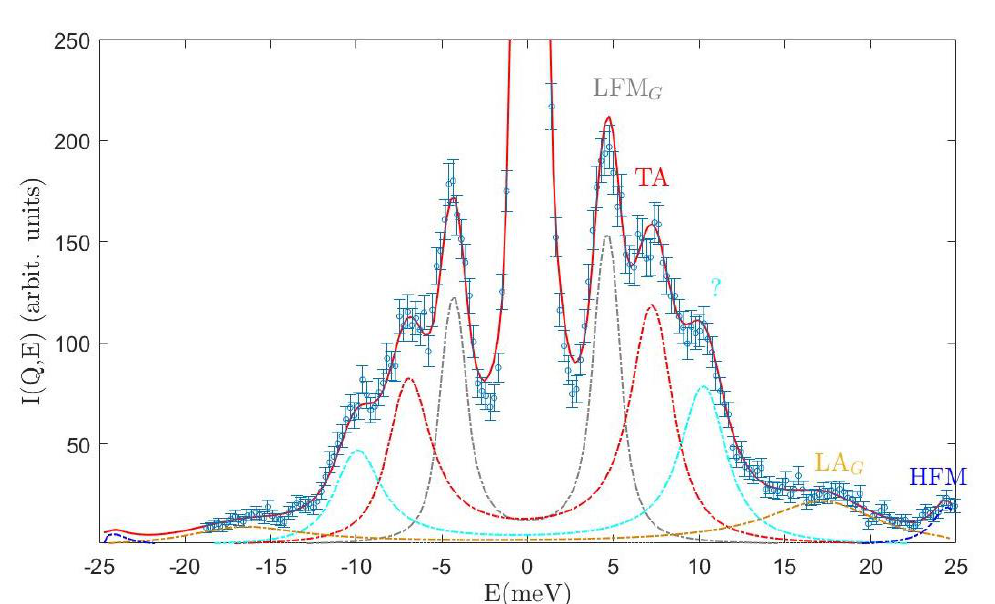
Figure 4. The spectrum of the frozen suspension at Q = 21 nm − 1 is compared with best-fitting lineshapes and the individual lineshape components. The corresponding color acronym indicates each spectral mode’s assignment: LFM G is a low-frequency mode associated to Au nanoparticles, TA (ice) transverse acoustic, LA G Au longitudinal acoustic, HFM high-frequency (ice) mode (see text). The question mark labels a not assigned mode as discussed in the text. The spectrum is displayed in an expanded y -scale to emphasize the shape of the inelastic features.